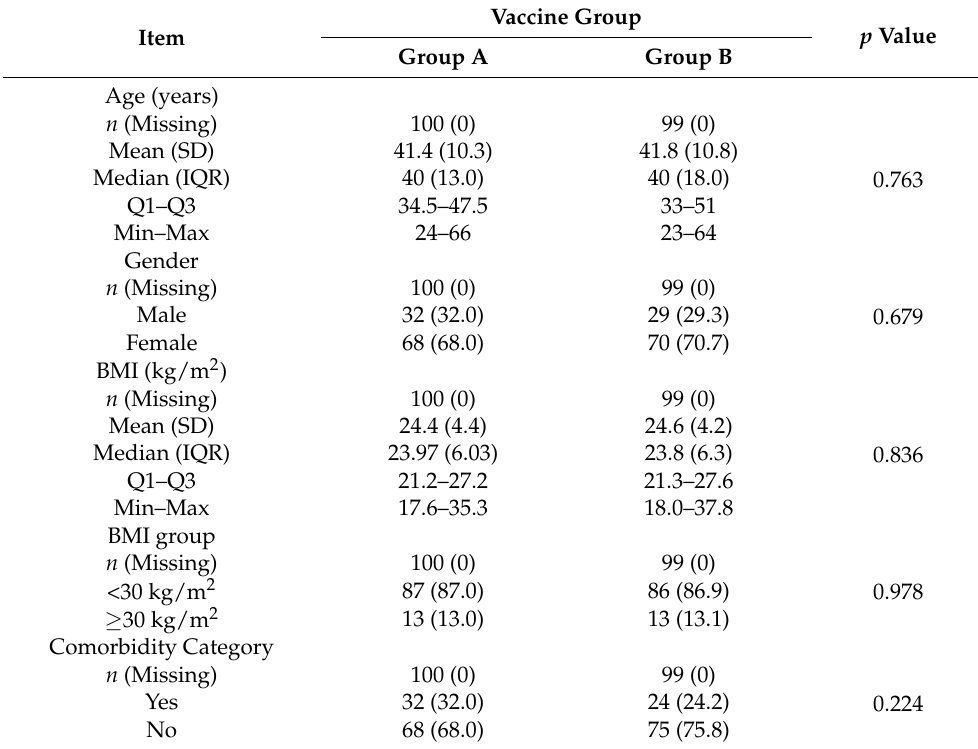
Table 1. Demographic profile of